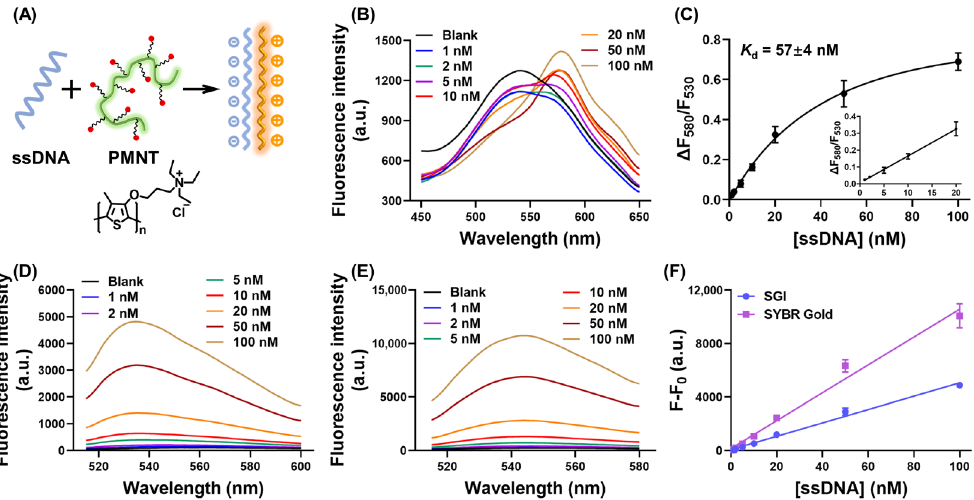
Figure 1. ( A ) Schematic representation of the CCP-based assay for ssDNA measurement. ( B ) The fluorescence spectra of PMNT upon adding different concentrations of ssDNA. The concentration of PMNT was 5 μM, as calculated by repeat units. ( C ) The fluorescence ratio changes of PMNT in response to ssDNA concentration. Inset: the linear response from 1 to 20 nM ssDNA. The fluorescence spectra of SGI ( D ) and SYBR Gold ( E ) after binding with different concentrations of ssDNA. The concentration of SGI and SYBR Gold was 0.5×. ( F ) The fluorescence intensity changes of SGI and SYBR Gold in response to ssDNA concentration.